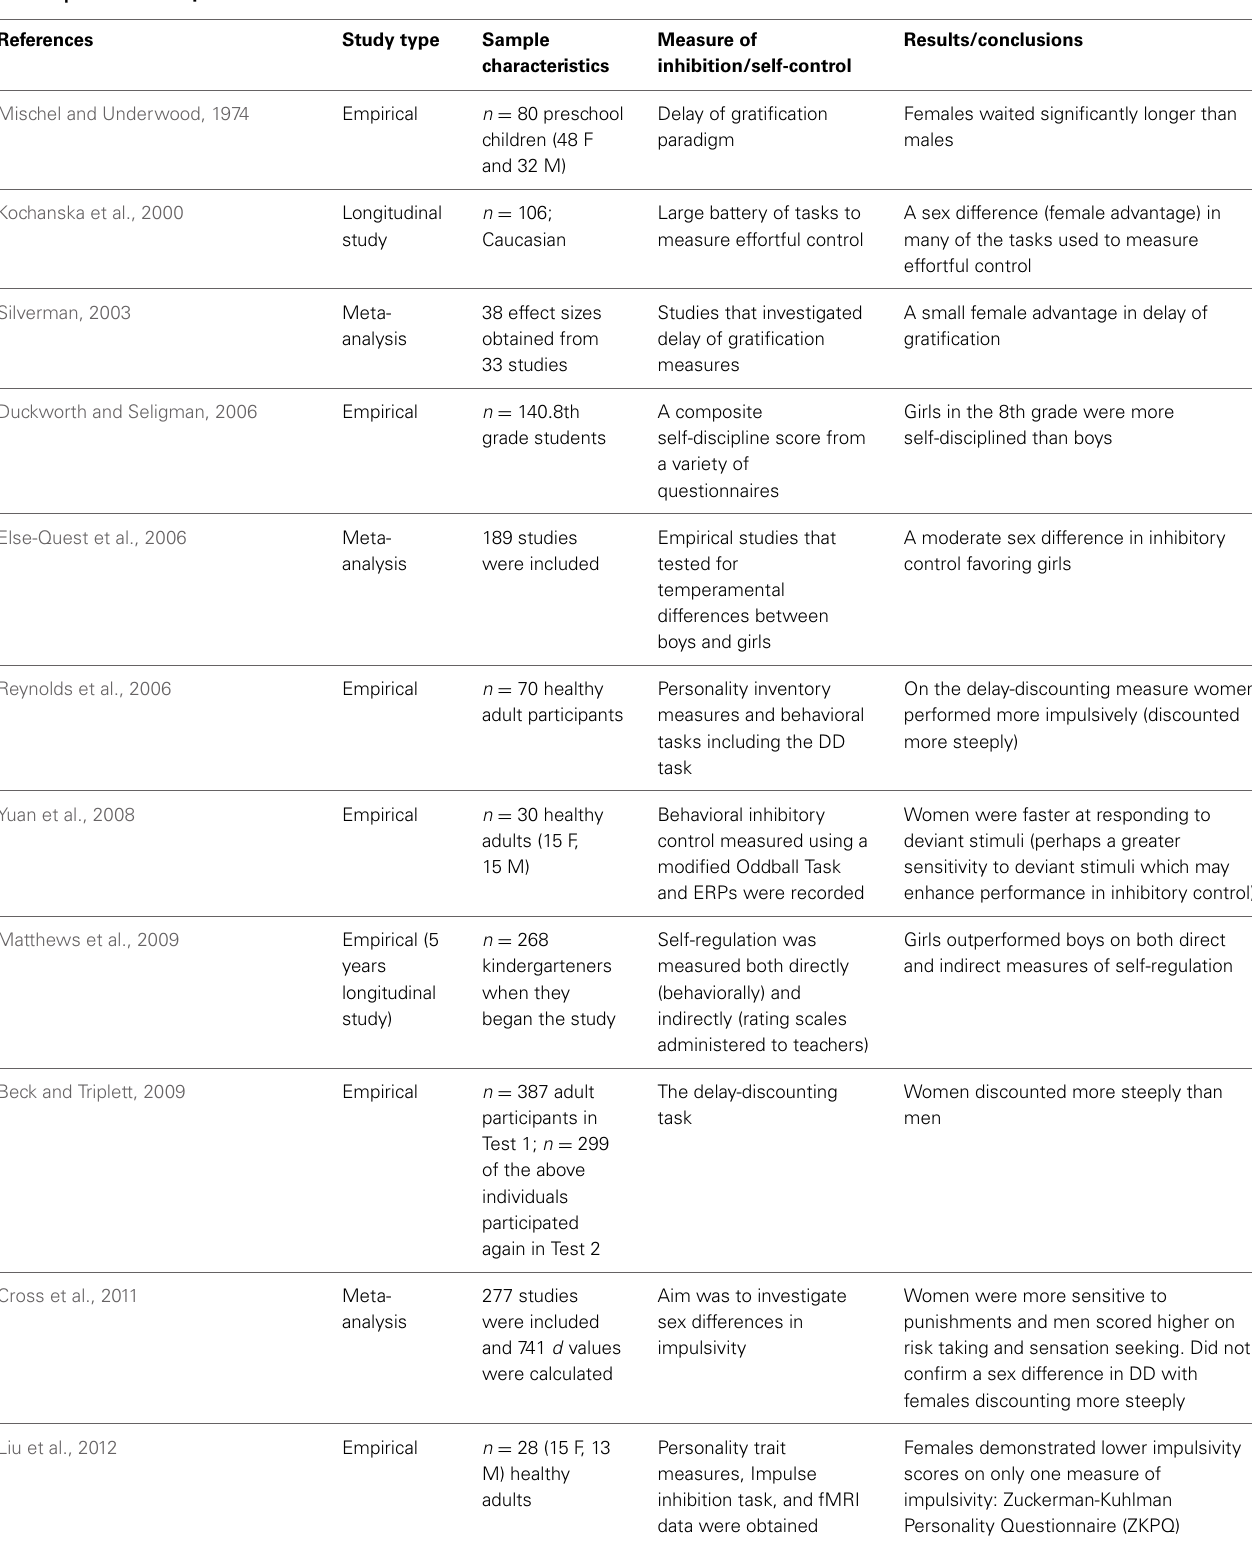
Table 1 | Sexual dimorphisms in inhibition at the behavioral